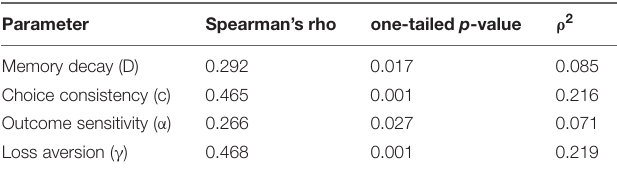
TABLE 6 | Summary of BIC difference scores of the 18 cognitive models relative to the baseline statistical model in the IGT and SGT among opiate users. Model Task Utility Updating function rule